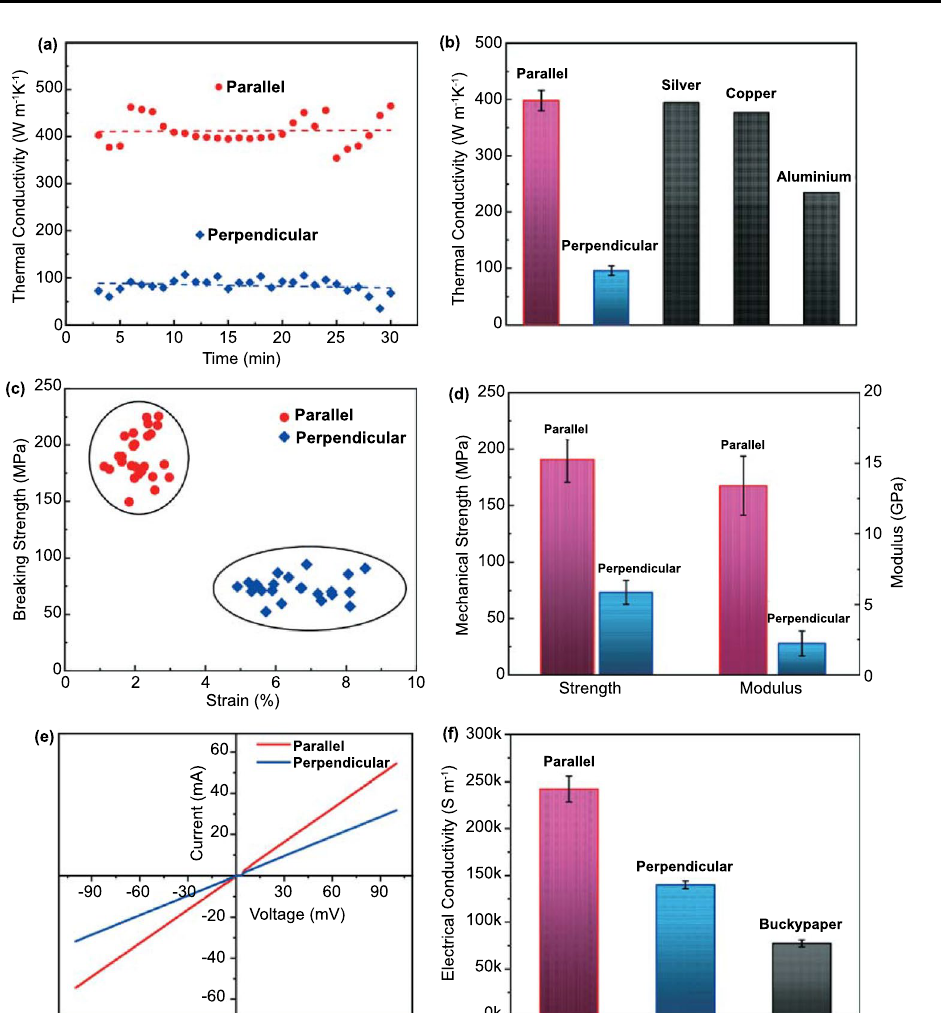
Fig. 2 Properties of as-prepared freestanding SWCNT film in parallel and perpendicular orientations. a Typical measured thermal conductiv- ity and b average thermal conductivity of SWCNT film in parallel and perpendicular directions, as well as some tested pure metal plates (silver, copper, and aluminum). c Scatter plots of as-prepared films’ tensile mechanical property measured and d average tensile strength and Young’s modulus of SWCNT films in parallel and perpendicular directions. e Typical I–V curves of SWCNT film and f average electrical conductivity of aligned SWCNT film in parallel and perpendicular directions as comparison to the random network SWCNT